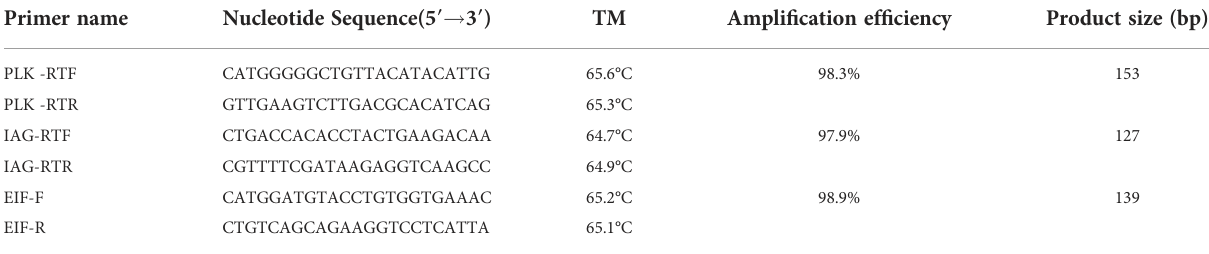
TABLE 3 q PCR primers used in this